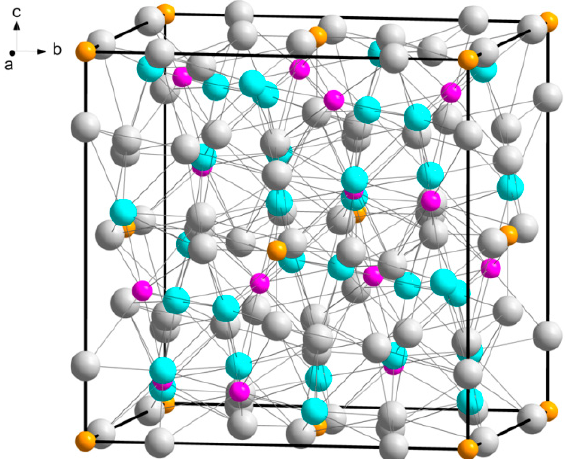
Figure 4. The crystal structure of tsikourasite. Grey and light blue circles refer to Mo and Ni atoms, respectively. Violet circles refer to the P1 position whereas orange spheres indicate the partially occupied P2 position. The unit cell and the orientation of the structure are outlined. Table 5. Calculated X-ray powder diffraction pattern for tsikourasite (Cu K α ). The strongest reflections are given in bold.